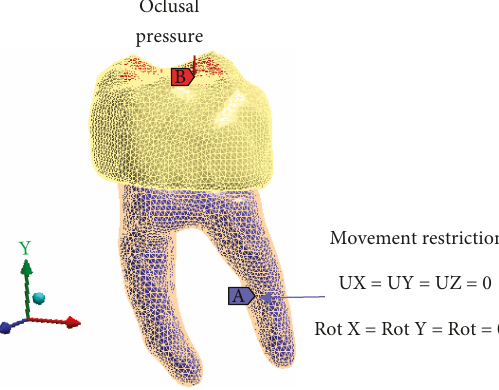
Figure 5: Applied loads and boundary